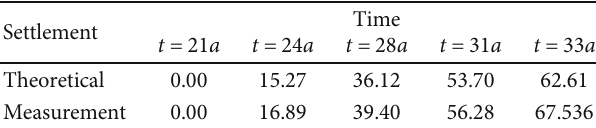
Figure 11: Comparison between theoretical and measurement value of concrete strain in each layer of shaft during di ff erent times. Table 3: Theoretical and measurement values of the settlement of west ventilation shaft.